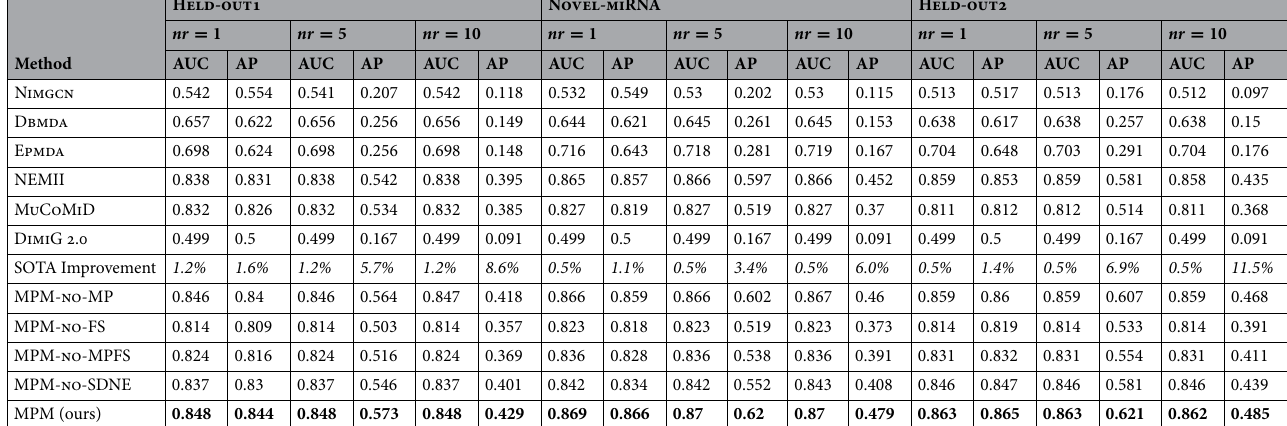
Table 2. Results for all models on the three large independent test sets. The percentage of improvement over the state-of-the-art models are in italics. nr = 1 , nr = 5 , nr = 10 indicate that we test all models with the positive:negative rates of 1:1, 1:5, 1:10, respectively. Bold font is used to highlight the best scores.